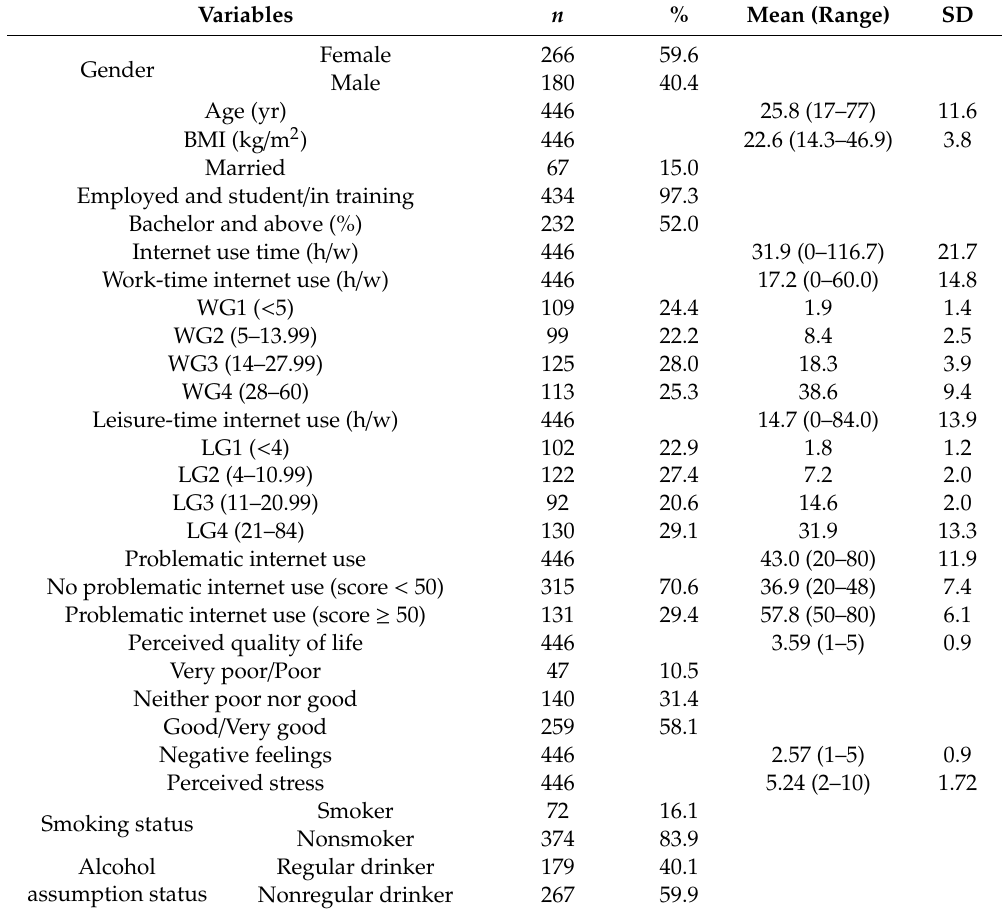
Table 1. Descriptive statistics of socio-demographics and main research